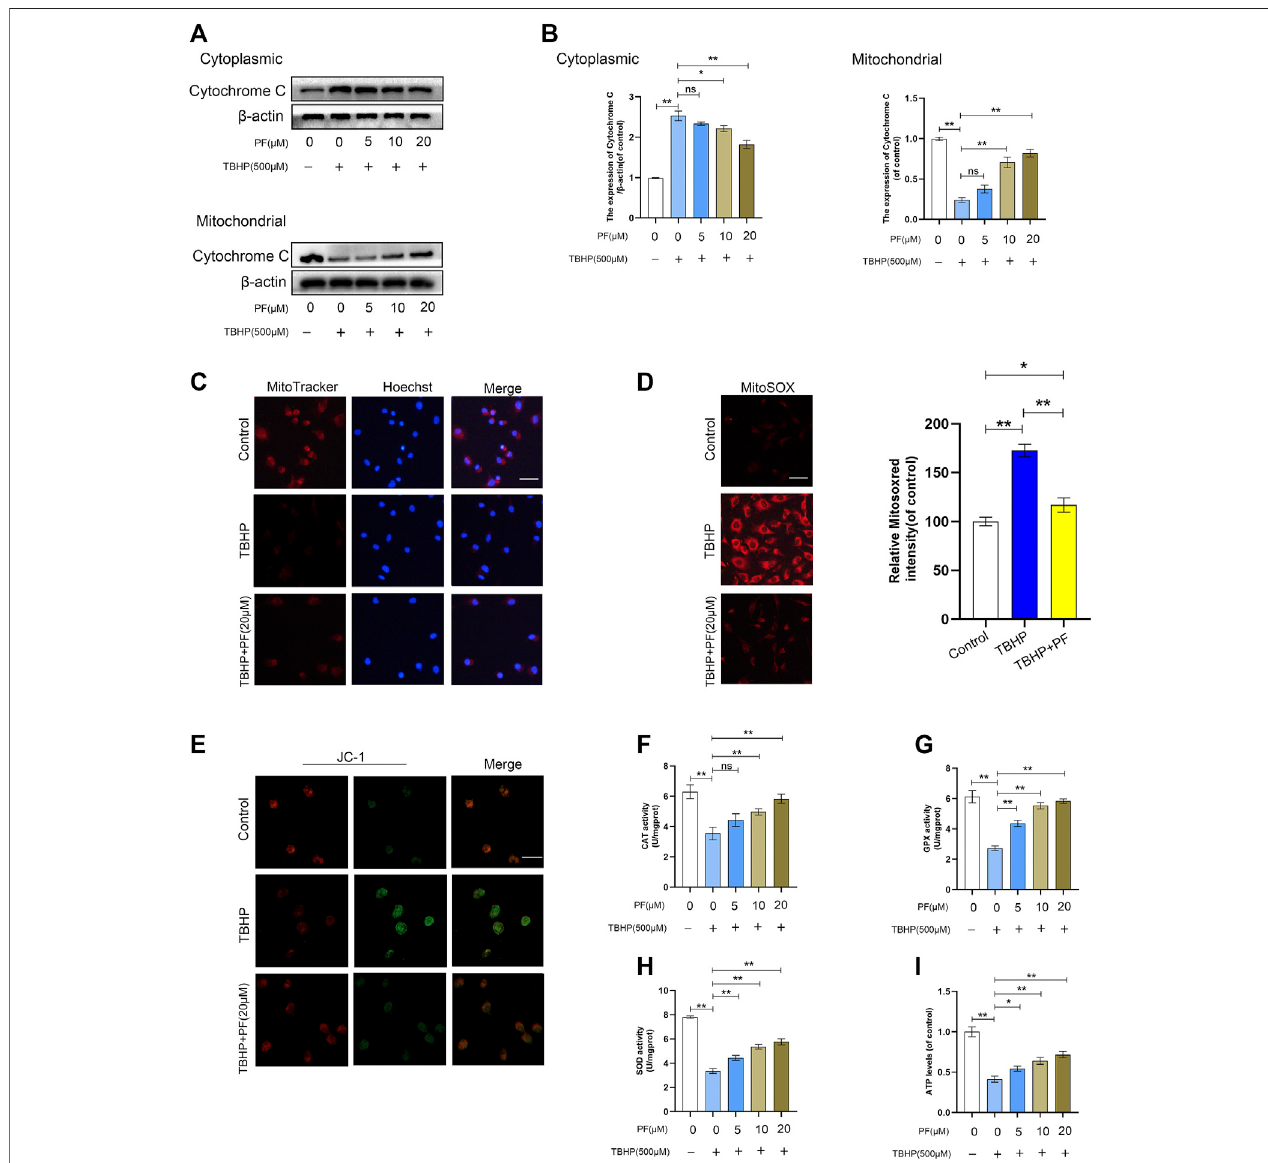
FIGURE 3 | Paeoni fl orin (PF) ameliorated TBHP-induced oxidative stress and mitochondrial functional damage in HUVECs. (A) Western blotting showing levels of cytoplasmicandmitochondrialcytochromeCunderdifferenttreatmentconditions. (B) Histogramshowingquanti fi cationalcomparisonofcytoplasmicandmitochondrial cytochrome C expressions in the PF (0 – 20 μ M) with or without TBHP (500 μ M) groups. (C) The cells were stained with 0.5 µM MitoTracker for 30 min, and nuclei were stained with Hoechest (blue). Immuno fl uorescence staining was performed and detected by using the Nikon ECLIPSE Timicroscope (Nikon, Japan). (bar: 20 μ m). (D) The cells were stained with 2 µM MitoSOX Red for 10 min and fl uorescence intensity was measured using a fl uorometer. Percentage values were calculated compared to those in the untreated group. (bar: 20 μ m). (E) JC-1 staining was performed to detect the mitochondrial membrane potential (MMP) (bar: 20 μ m). (F – G) Activities of CAT, GPx, and SOD in the differentially treated HUVECs. (H) Activity of ATP in different treatment groups. Data: mean ± SD, * p < 0.05 and ** p < 0.01. n (cid:2) 3.